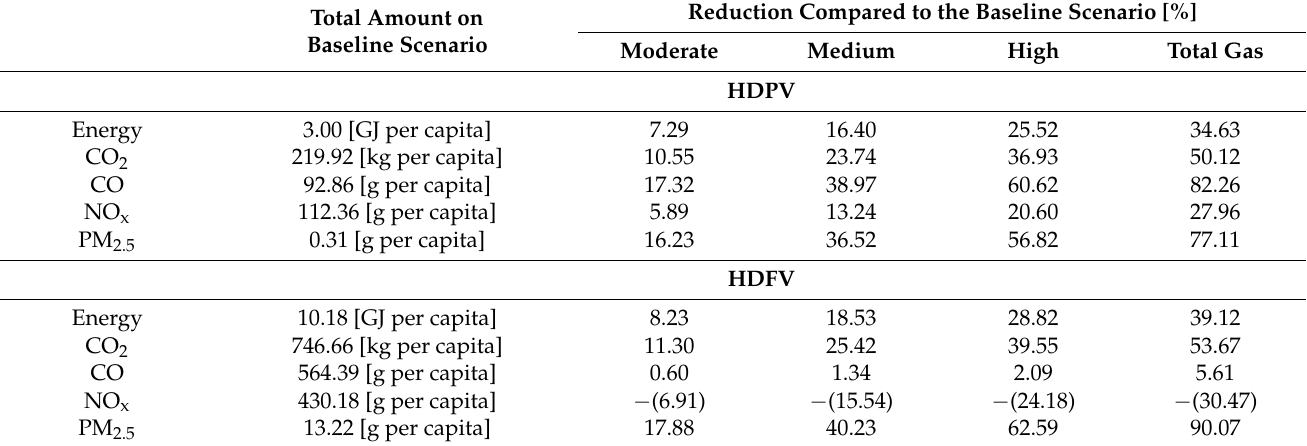
Table 5. Reduction of emissions and energy consumption by